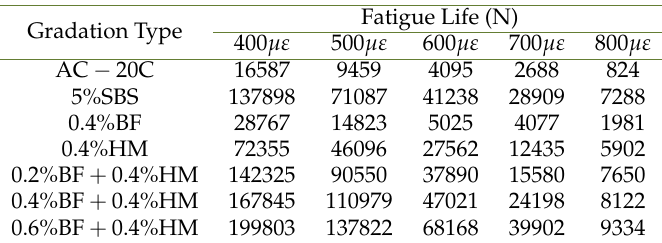
Table 5. Asphalt mixture fatigue test